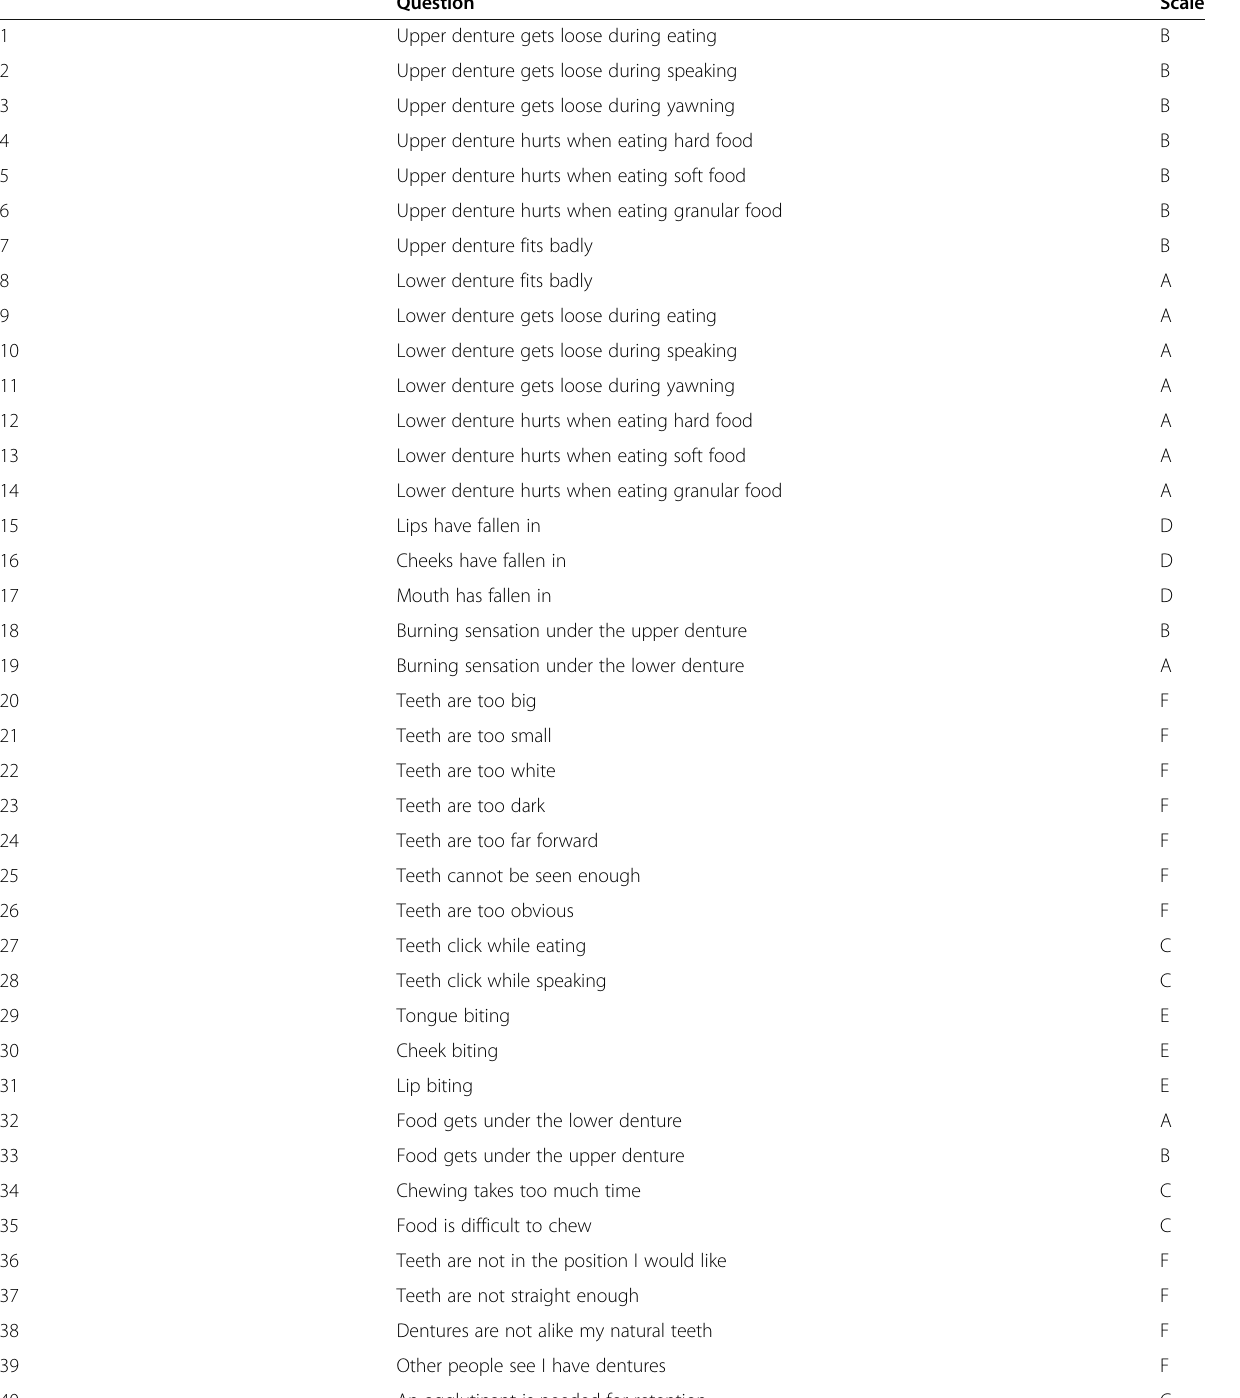
Table 5 Questions of patient satisfaction questionnaire divided into six scales (A, functional problems of the lower denture; B, functional problems of the upper denture; C, functional problems complaints in general; D, facial esthetics; E, accidental lip, cheek, and tongue biting “ neutral space ” ; F, esthetics of the